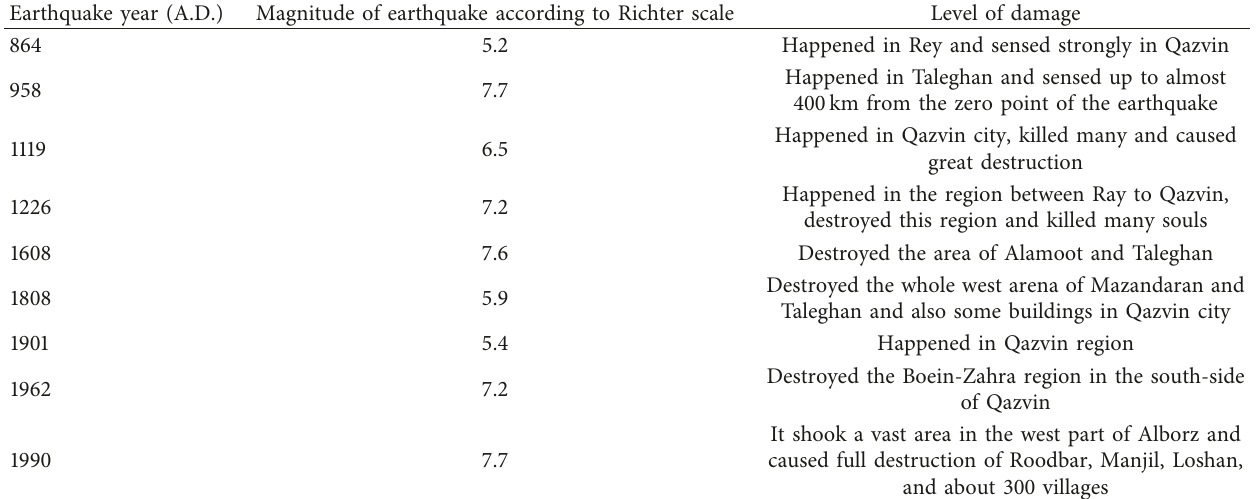
Table 3: Major earthquakes in